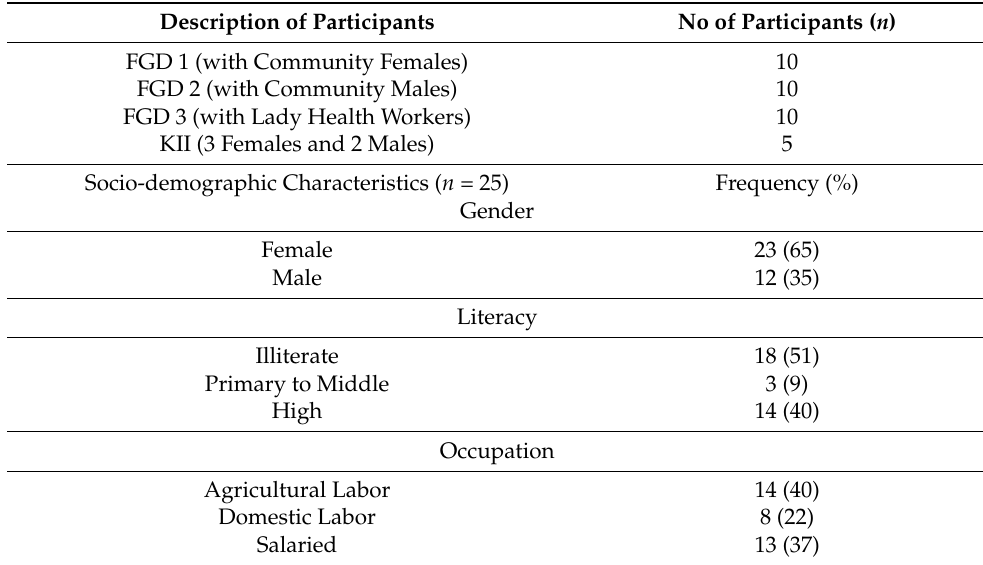
Table 1. Socio-demographic Characteristics of FGDs and KI Participants ( n =